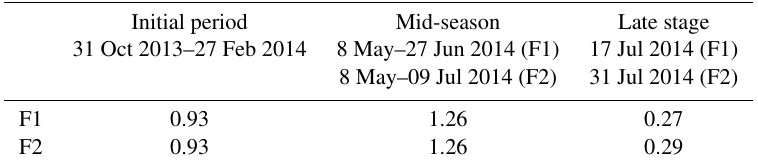
Table 1. Crop coefficients ( K c ) of winter wheat in the stony (F1) and silty (F2) soils in different growing periods. K c was calculated according to Allen et al. (1998).